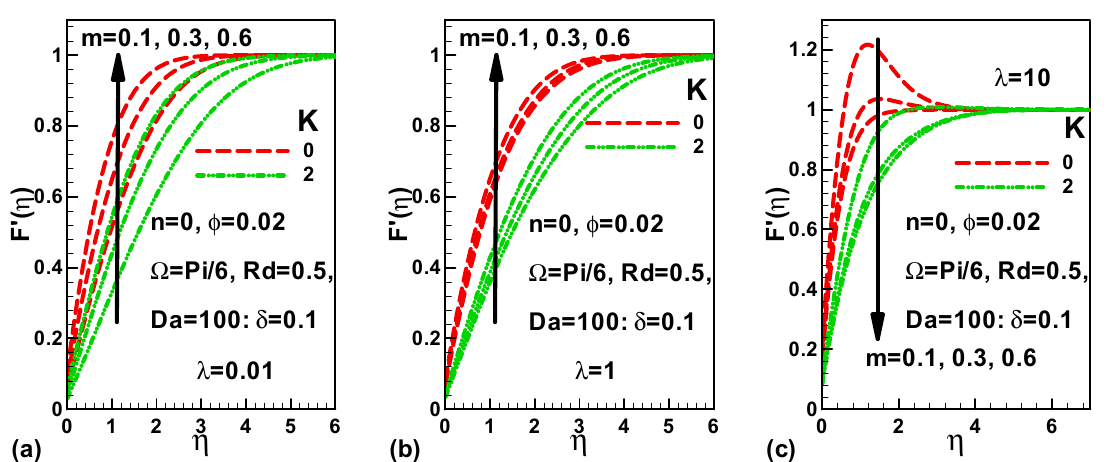
Figure 2. Variation of dimensionless velocity with pressure gradient parameter for ( a ) forced convection, ( b ) mixed convection, and ( c ) free convection.